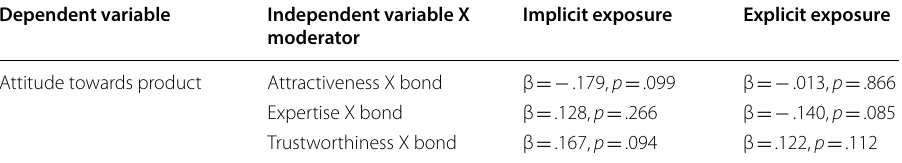
Table 15 Moderated regression analysis result of emotional bond on relationship between vloggers’ attributes and attitude towards product depending on product exposure